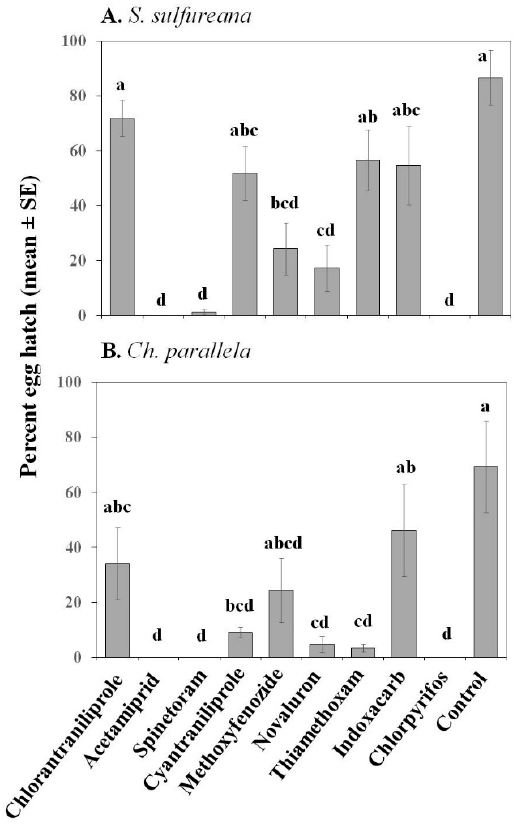
Figure 1. Effect of various insecticides on egg hatch for Sparganothis sulfureana ( A ) and Choristoneura parallela ( B ). Bars with the same letter are not significantly different at α = 0.05.